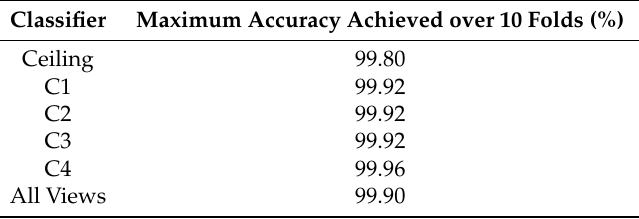
Table 2. The average accuracy over 10 folds for each Convolutional Neural Network (CNN) along with the average for all five CNNs together where C = corner